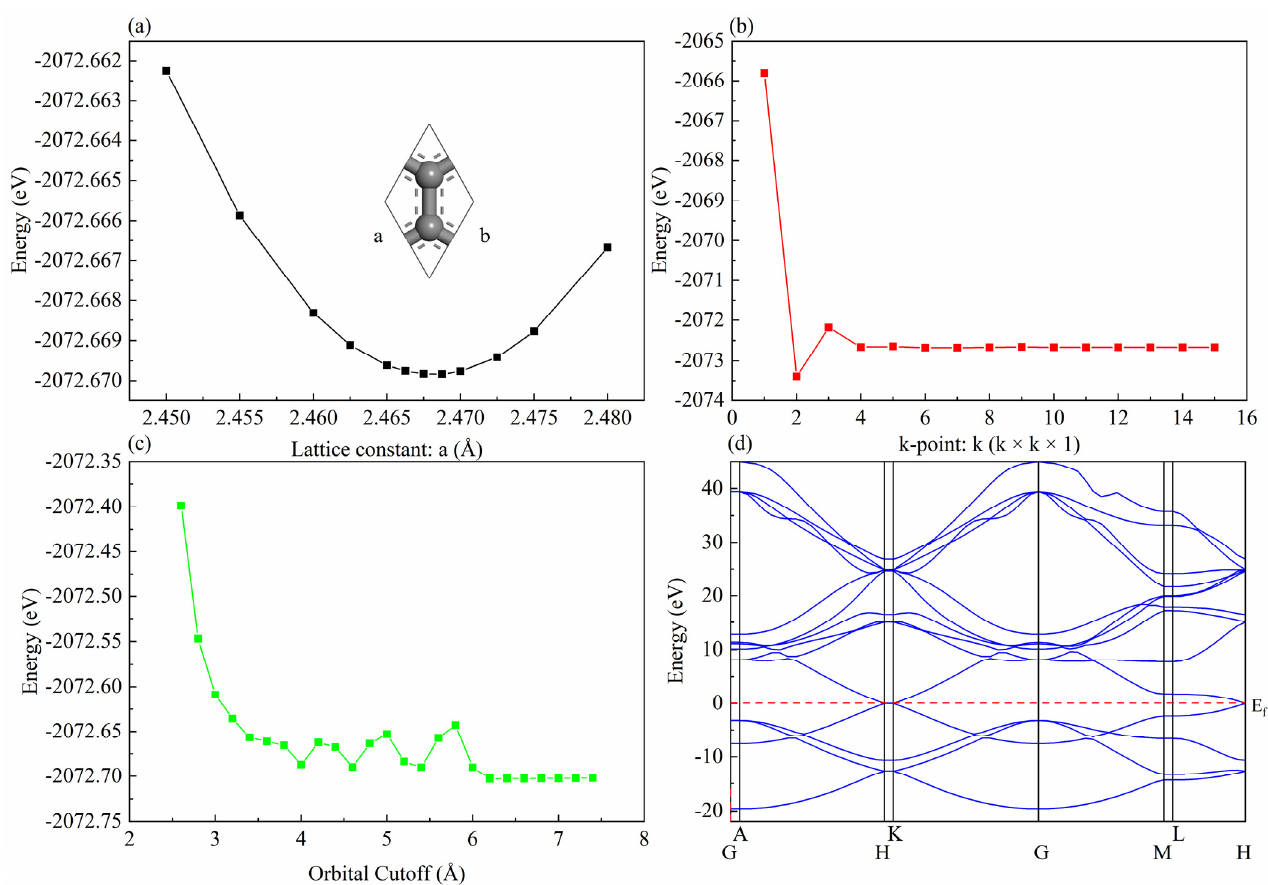
Figure 1. The convergence tests: ( a ) lattice constant, ( b ) k-point, ( c ) orbital cutoff, ( d ) band structure.